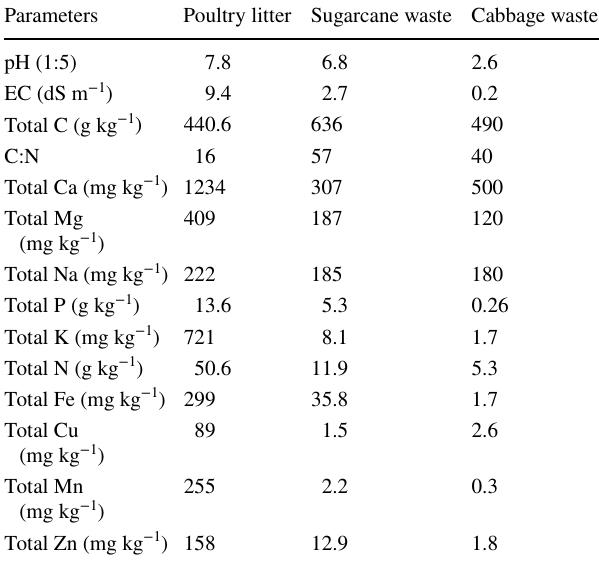
Table 1 Chemical properties of poultry litter and agro-wastes before composting